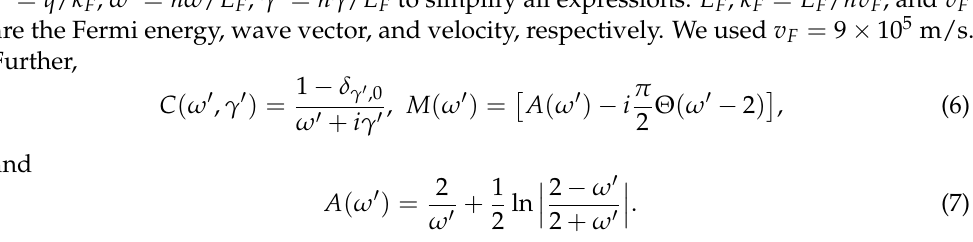
Figure 1. 3D bar and contour plot of the real and imaginary parts of the polarization function χ in the absence of